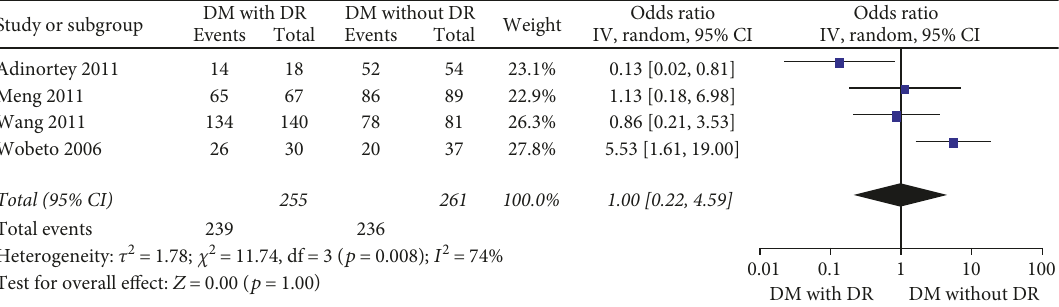
Study or subgroup